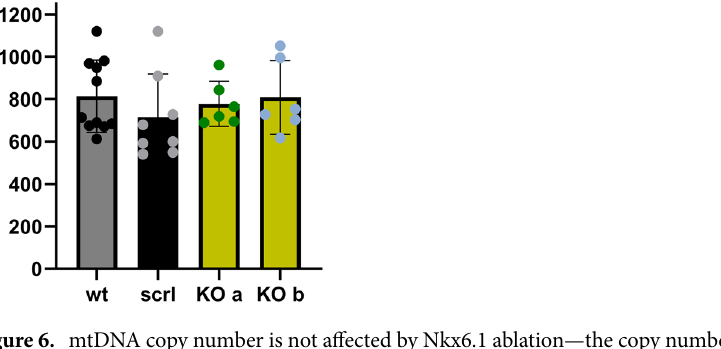
Figure 6. mtDNA copy number is not affected by Nkx6.1 ablation—the copy number evaluated as described in “Methods” is compared for parental INS-1E cells (wt, gray ; number of passages N was 6), INS-1E scrl/scrl cells ( black N was 4) and line a ( green, green points ) and line b ( green, blue points ) of INS-1E Nkx6.1 – / – cells ( N was 3 for each).